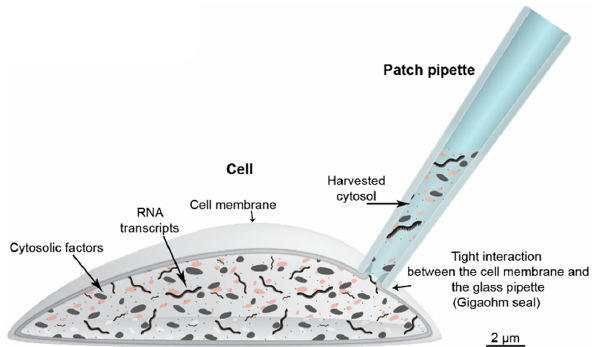
Figure 5. Harvesting of the cell’s cytosol using a patch pipette. The technique is usually performed on tissue slices and combines patch-clamp electrophysiological recordings with analysis of gene transcripts. Following the electrophysiological experiments the cytosol from the cell may be harvest into the pipette using gentle suction. When the harvesting is finalized the tip of the pipette is withdrawn from the cell. During the final process membrane fragments reseals the tip of the patch pipette and protects the harvested RNA from contaminations in the surrounding solution. Silanizing the glass surface will also prevent extracellular RNA from attaching to the pipette.